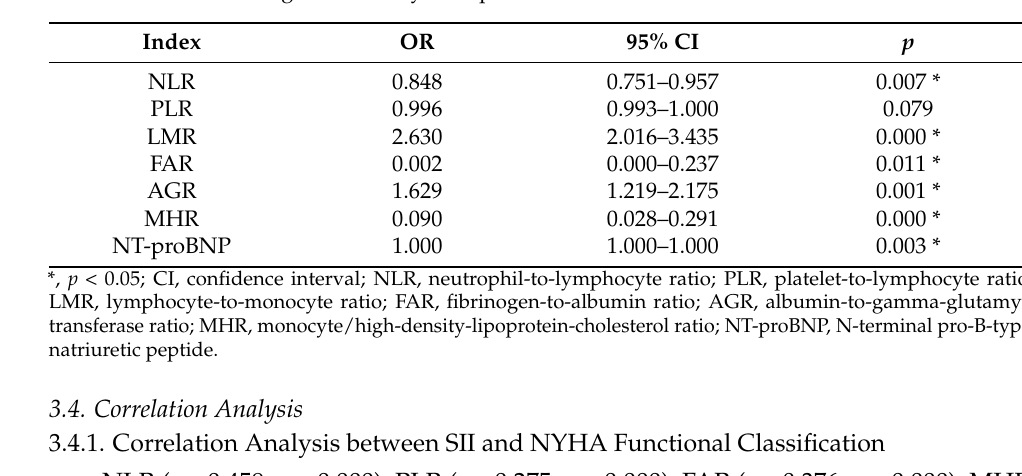
Table 4. Multivariate regression analysis of predictors for increased NYHA functional classification.